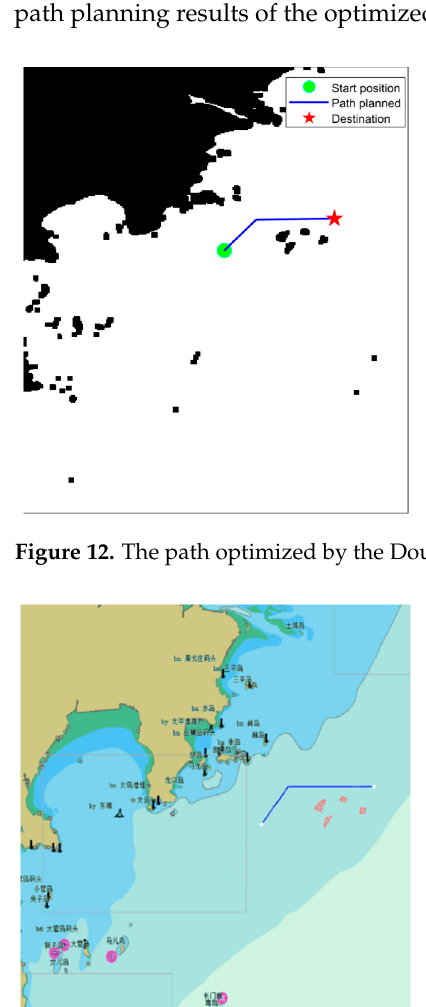
Table 2. The number of path corners and path length before and after optimization by DP.